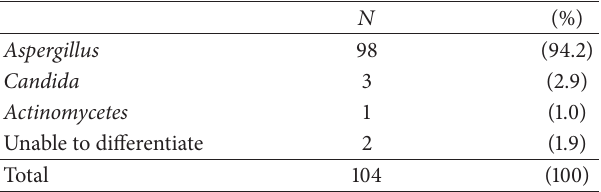
Table 4: Histological examination of fungus ball.